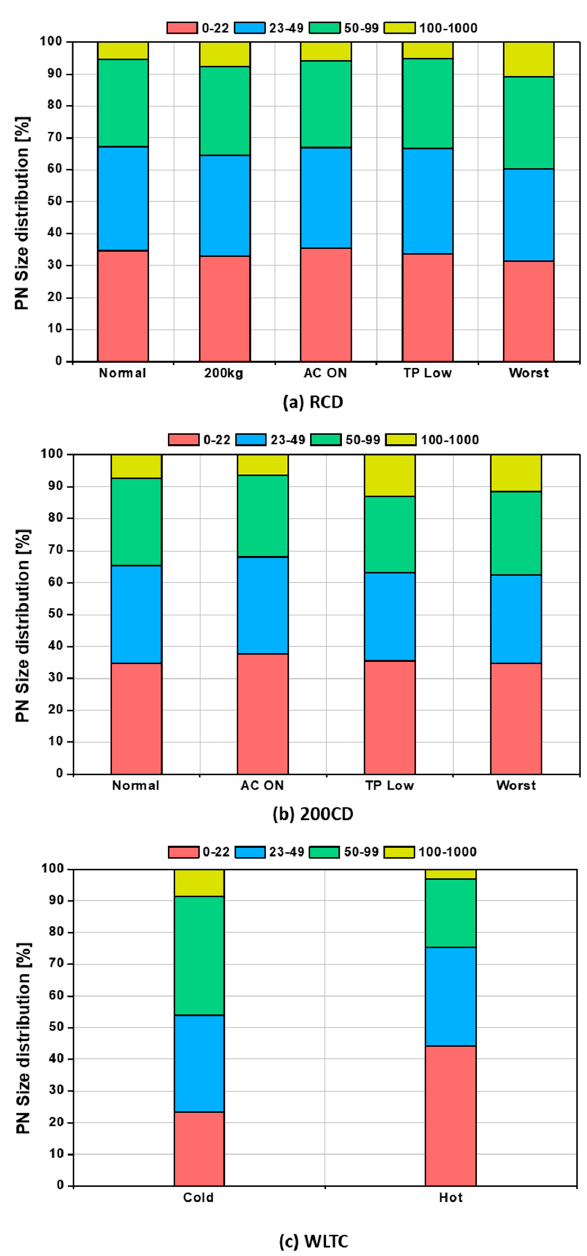
Figure 7. Size distribution of PN emissions with various CD values and in WLTP mode; red bar indicates PN size ranged 0 to 22 nm, blue bar indicates 23 to 49 nm, green bar indicates 50 to 99 nm and yellow bar indicates PN sized over 100 nm.